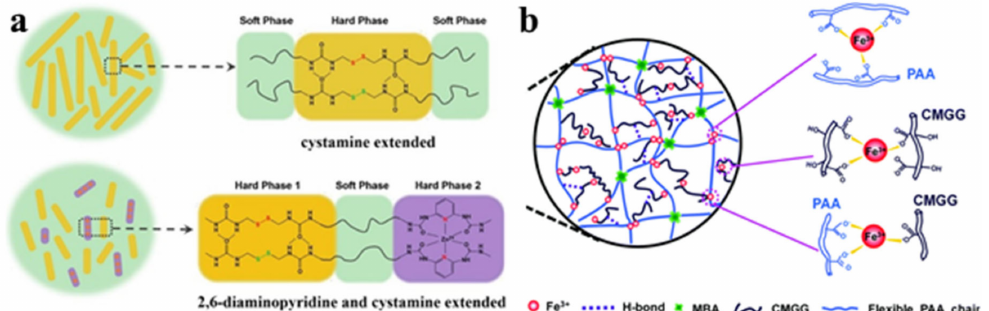
Figure 49. ( a ) Illustration of phase morphology for PU elastomers. Reproduced from [219] with permission from Elsevier. ( b ) Schematic representation of the formation of H-bonds and multiple M–L bonds in hydrogels, where CMGG is carboxymethyl guar gum. Reproduced from [220] with permission from The Royal Society of Chemistry.